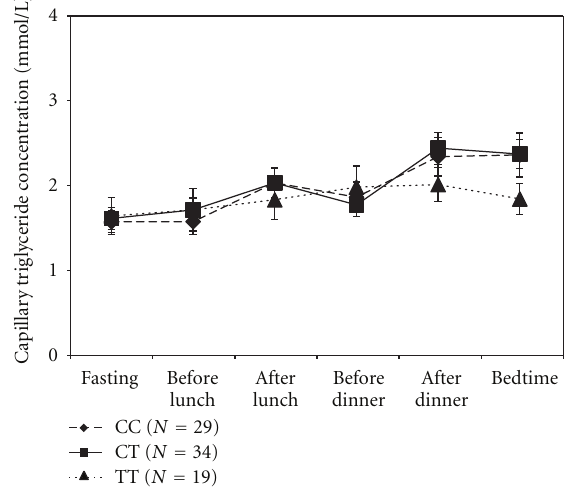
Figure 2: Diurnal capillary triglyceride patterns for C573T poly- morphisms. No significant di ff erences for the polymorphisms were found in the incremental area under the capillary triglyceride curve as a marker for postprandial